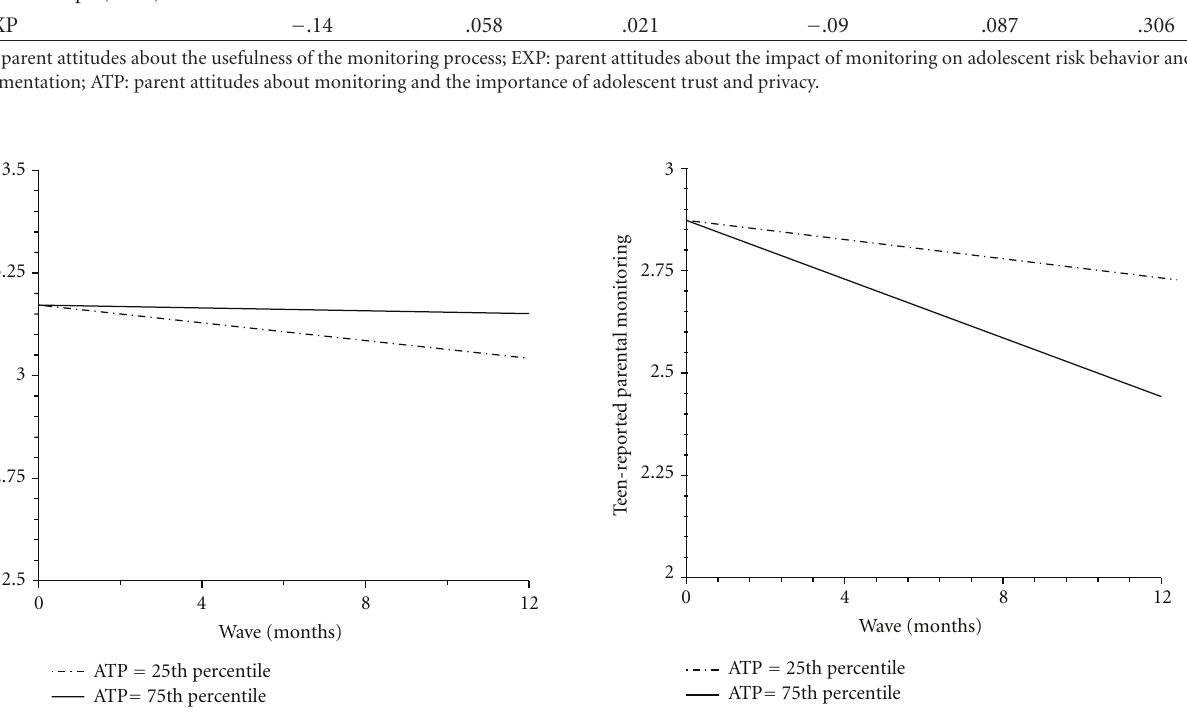
Figure 2: Teen-reported parental monitoring slopes at di ff erent levels of ATP. ATP: parent attitudes about monitoring and the importance of adolescent trust and